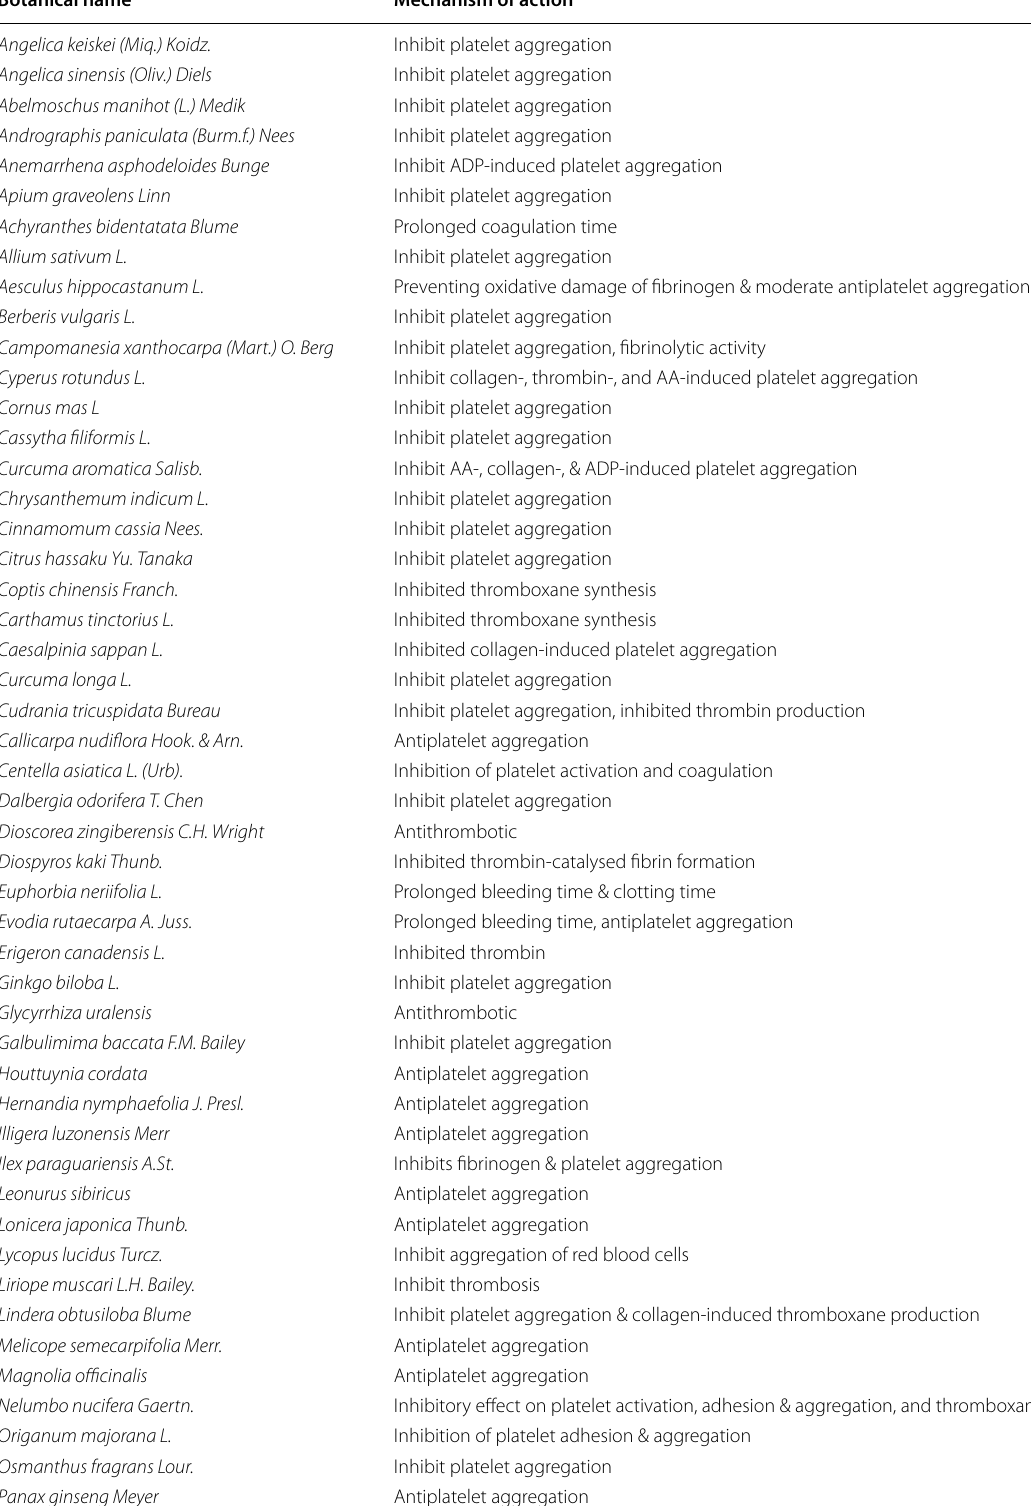
Table 2 List of herbal sources with mechanisms of its pharmacological